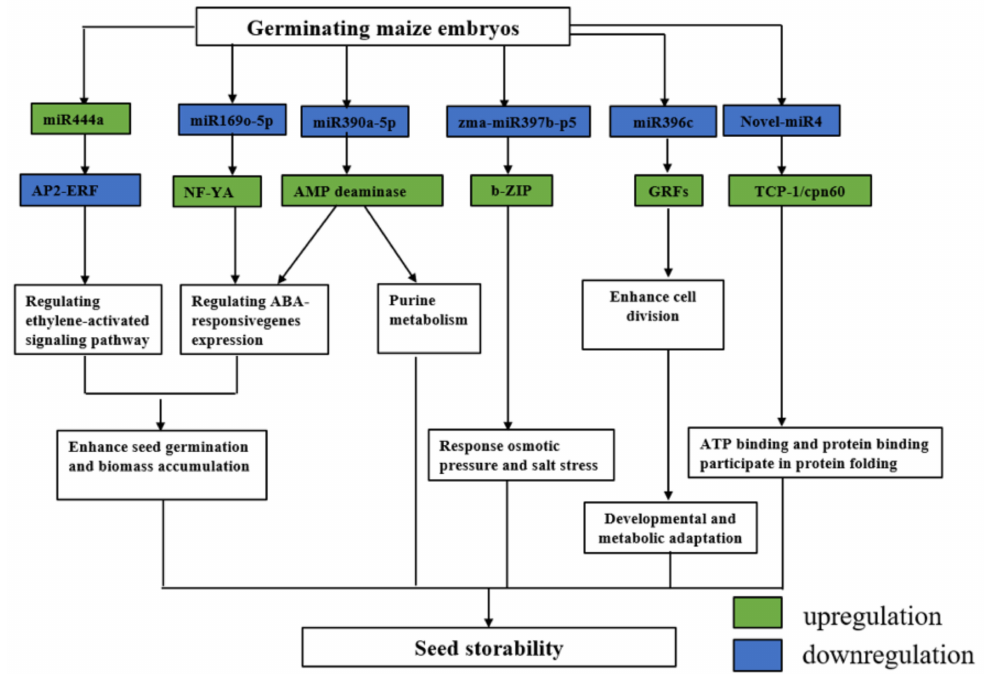
Figure 7. Possible microRNAs-dependent regulatory pathways that participate in seed storability during maize